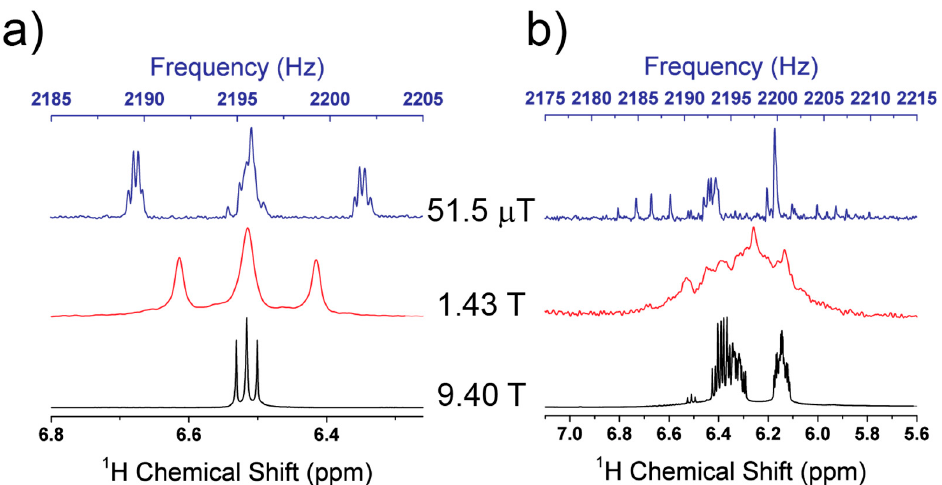
Figure 1. Comparison of the 1 H spectra for 1,4-difluorobenzene ( a ) and 1,2,4-trifluorobenzene ( b ) using a superconducting high magnetic field (9.4 T, black), a permanent high magnetic field (1.43 T, red), and permanent low field magnetic field (51.5 µ T, blue). The high field spectra are plotted on a chemical shift axis (bottom scale) and the low field spectrum is plotted on a frequency axis (top scale). As the field is decreased, in the high field regime, there is significant overlap of the peaks, which becomes problematic when multiple chemical shifts are present (b). The low field NMR spectrum has additional peaks in the spectrum that are not captured by either high field spectrum, and also provides fewer overlapping resonances in the case of the 1,2,4-trifluorobenzene